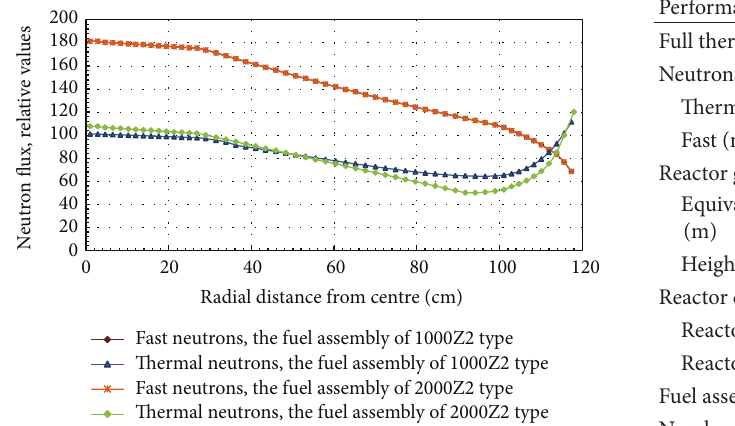
Figure 5: Radial flux density distribution of fast and thermal neutrons in the large core.